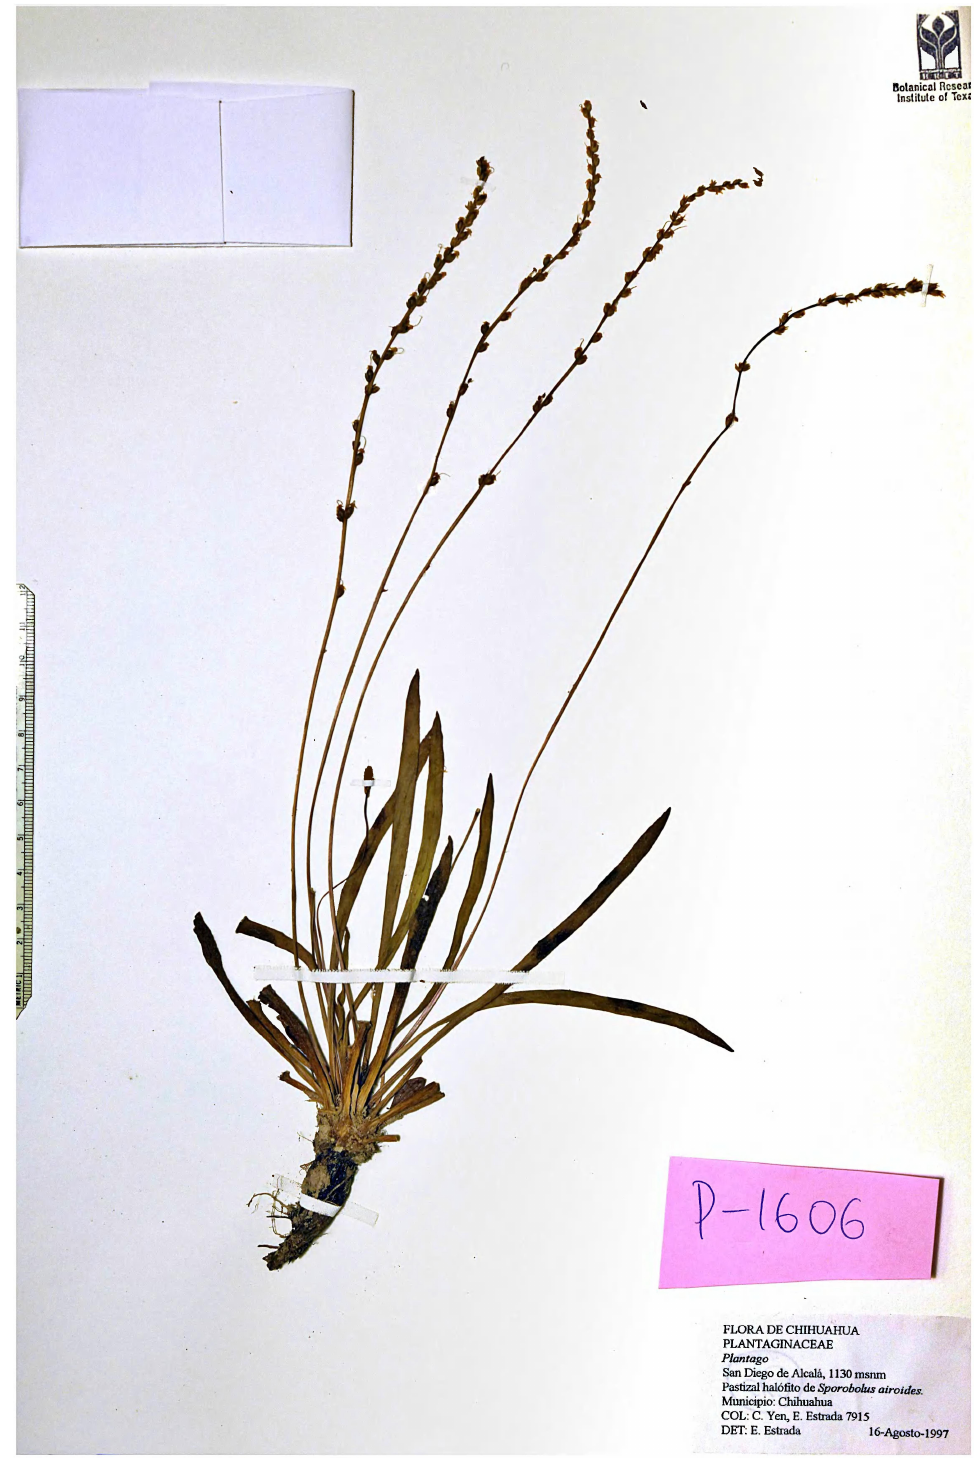
Figure 11. Plantago chihuahuensis , photograph of the herbarium sample (holotype, BRIT). The southern tetraploid forms similar to Plantago media but with thick, erect, grayish leaves ([53,73]), often regarded as P. urvillei Opiz or P. media subsp. stepposa (Kuprian.) Soó are distant from P. media s.str. (Figure 5C), thus necessitating the separation of this taxon. However, the diversity of P. media s.l. is still far from being fully understood ([74]), and more research is needed to draw robust taxonomic conclusions. Here should be noted